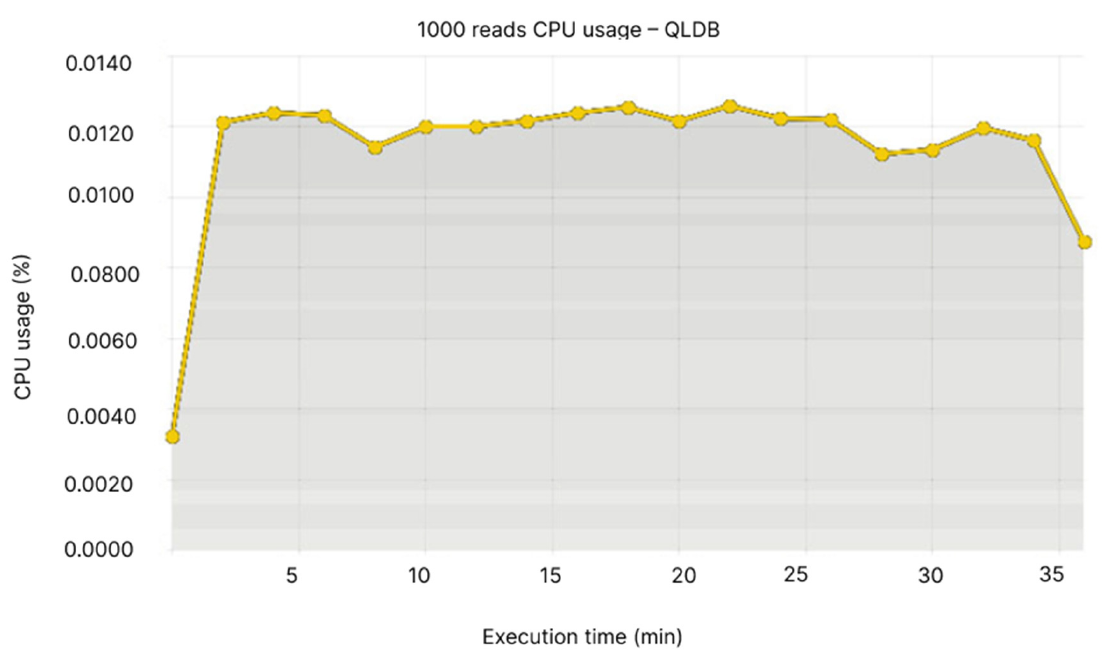
Figure 19. 1000 reads CPU usage—QLDB.